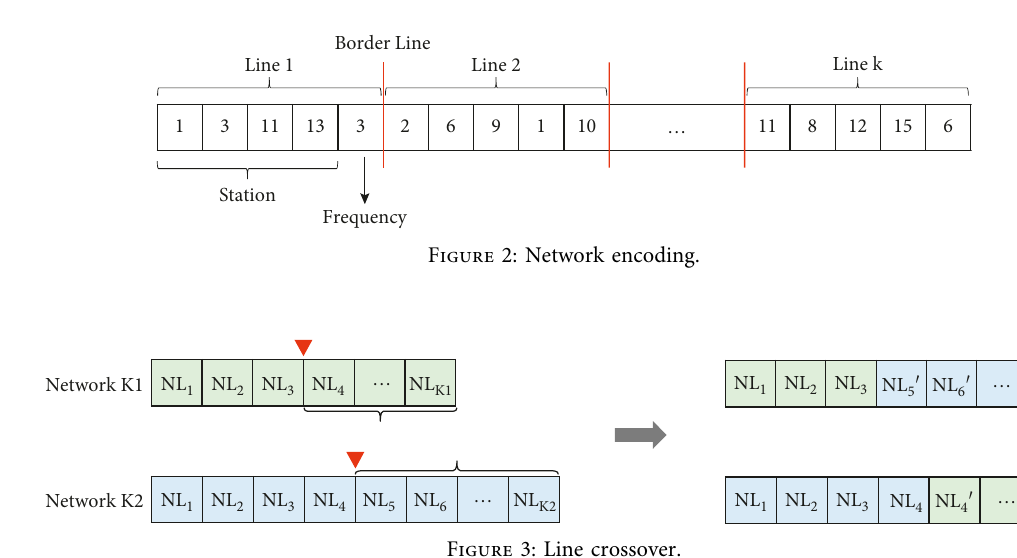
Figure 3: Line crossover.